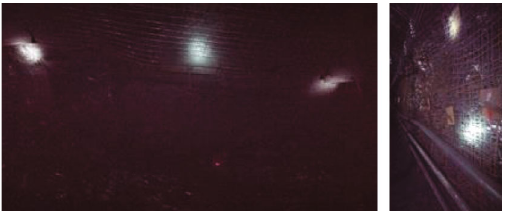
Figure 7: In situ roadway